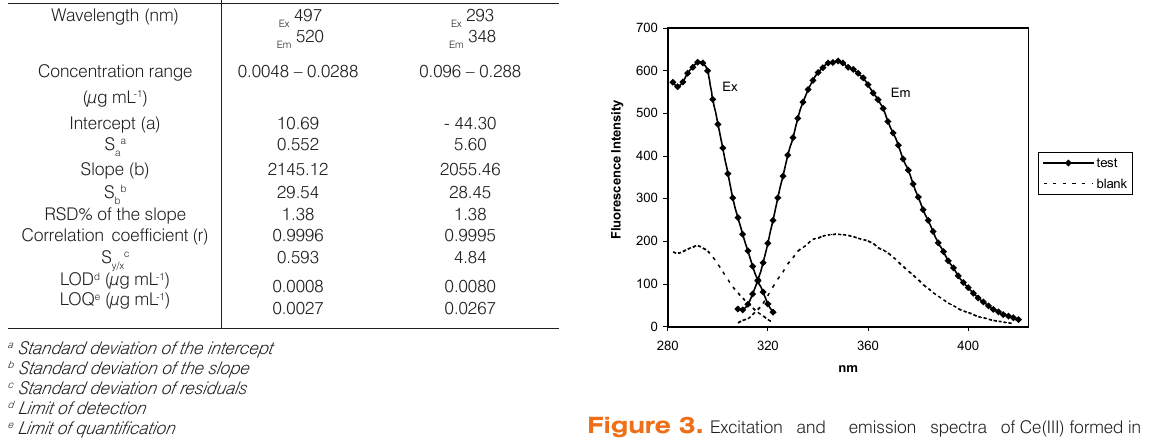
Figure 3. Excitation and emission spectra of Ce(III) formed in absence and in presence of 0.12 μg mL -1 PNC. Table 2. Precision and accuracy for the determination of penicillamine in bulk form using the proposed methods.